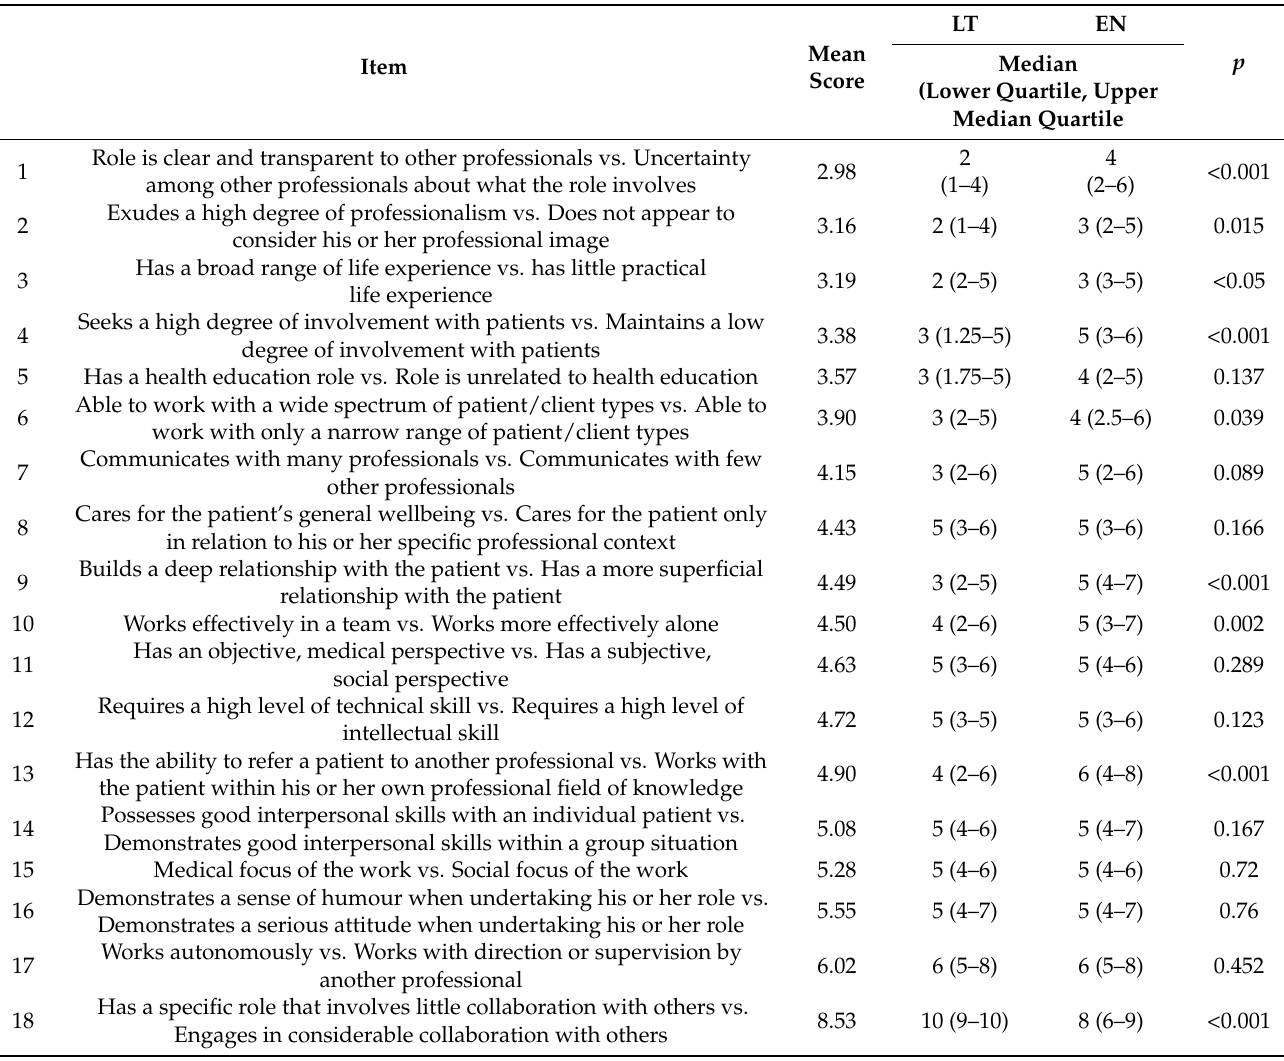
Table 1. Medical students’ attitudes towards the work of